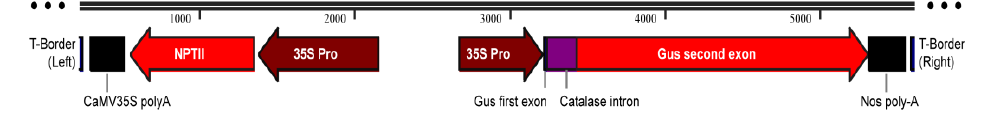
Figure 7. Schematic representation of T-DNA from pCAMBIA2301 showing the neomycin- phosphotransferase II ( nptII ) and GUS reporter gene ( uidA ) driven by the constitutive 35S promoter (35S Pro).